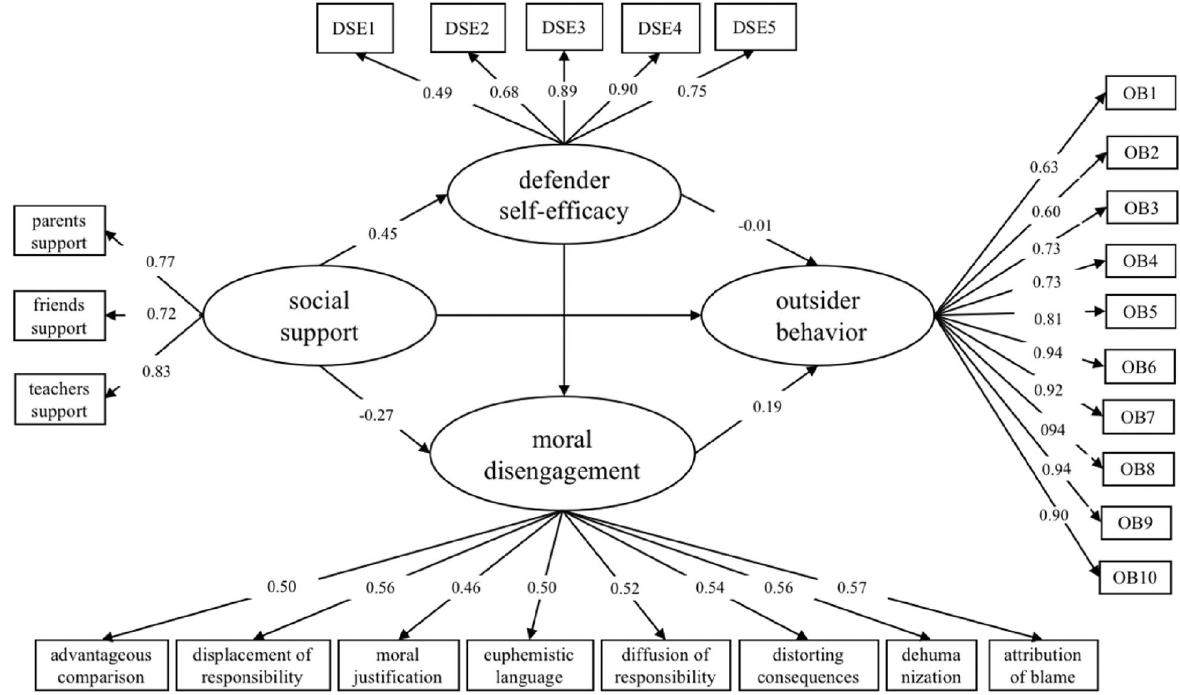
Fig. 4 The mediating effect of defender self-efficacy and moral disengagement in the relationship between social support and outsider